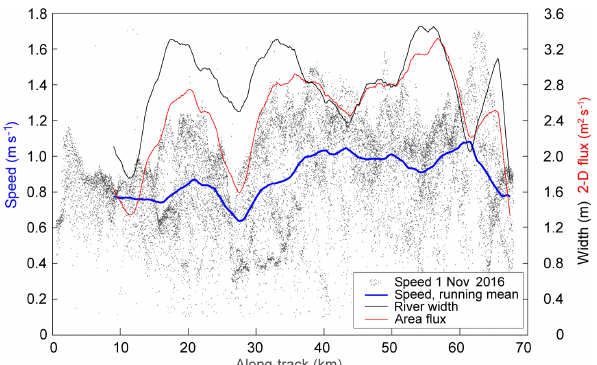
Figure 7. Longitudinal profile of mean speeds and river widths de- rived from near-simultaneous Planet cubesat images from 1 Novem- ber 2016 over a reach of the Amur River (Fig. 5). Small dots rep- resent individual speed measurements; the blue line represents the 4km running mean of individual measurements; the black line rep- resents the river width from velocities (running mean); the red line represents the surface area flux as a product of cross-sectional aver- age speed and river width (running